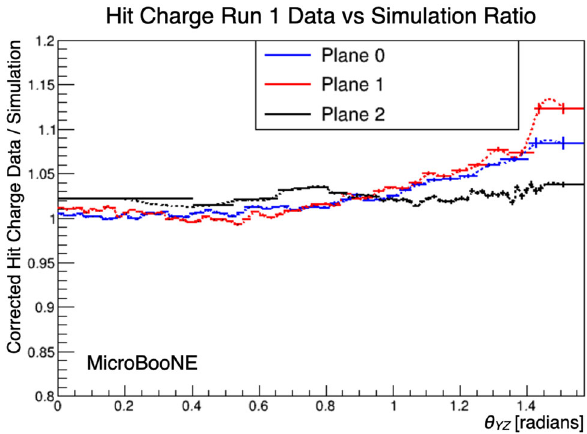
Fig. 9 Ratio functions (data/simulation) for hit charge vs. θ YZ . The solid lines are the values of the ratio in each bin, and the dashed lines are the spline fits. The bin at 1 . 4 < θ YZ < π/ 2 rad is extrapolated as described in the